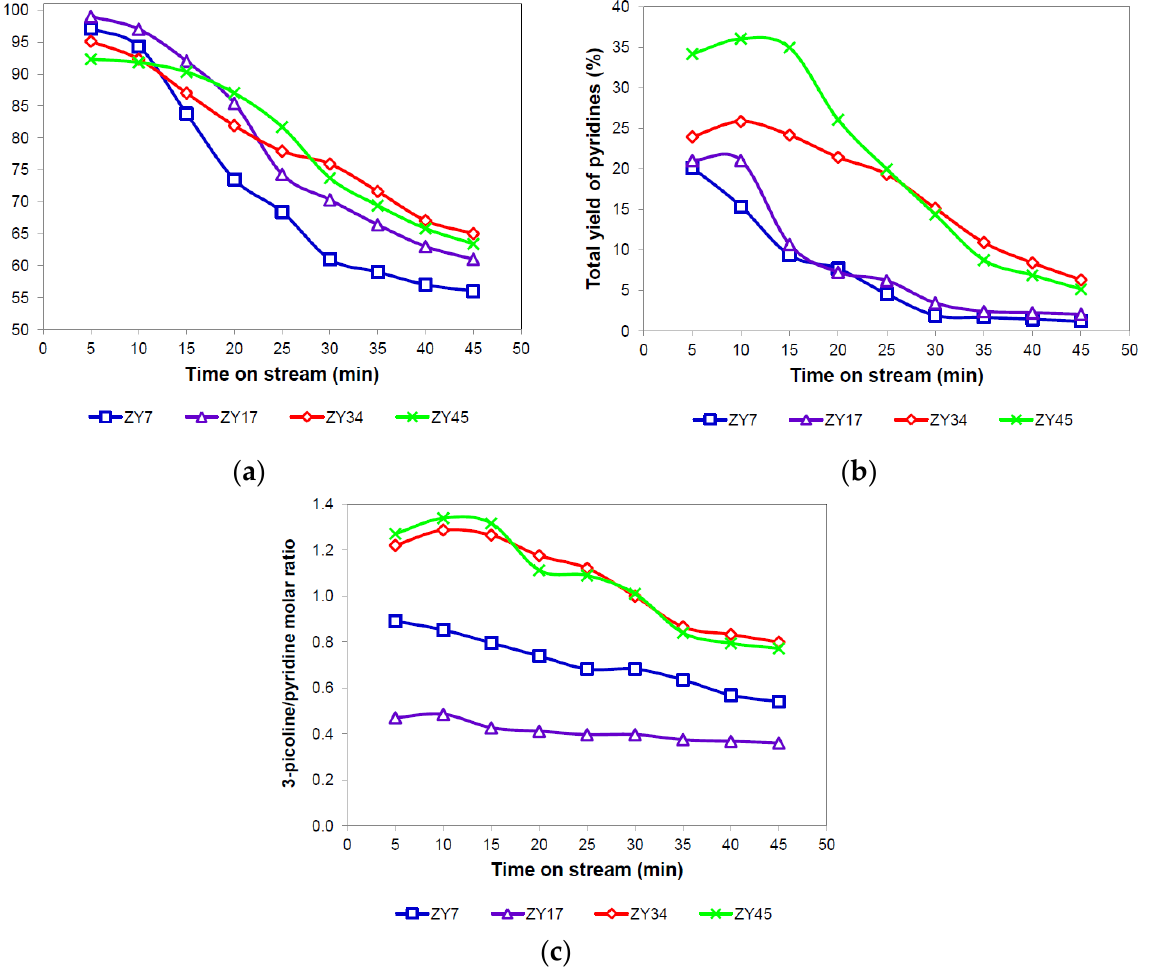
Figure 9. ( a ) Acrolein conversion, ( b ) total yield of pyridines, and ( c ) 3-picoline/pyridine molar ratio over the Y-type zeolites with time on stream.